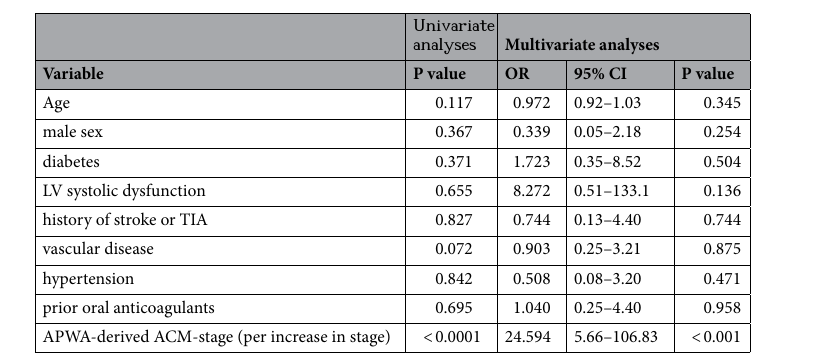
Figure 3. Amplified P-wave analysis identifies patients with left atrial thrombus. Overview of ACM-stages (ACM-stage 1 in green, ACM-stage 2 in orange, ACM-stage 3 in red) in patients with LAA-thrombus and matched control patients ( A ). APWA-derived ACM stages according to the presence or absence of LAA- thrombus are shown in (B) . APWA amplified P-wave analysis, ACM atrial cardiomyopathy.